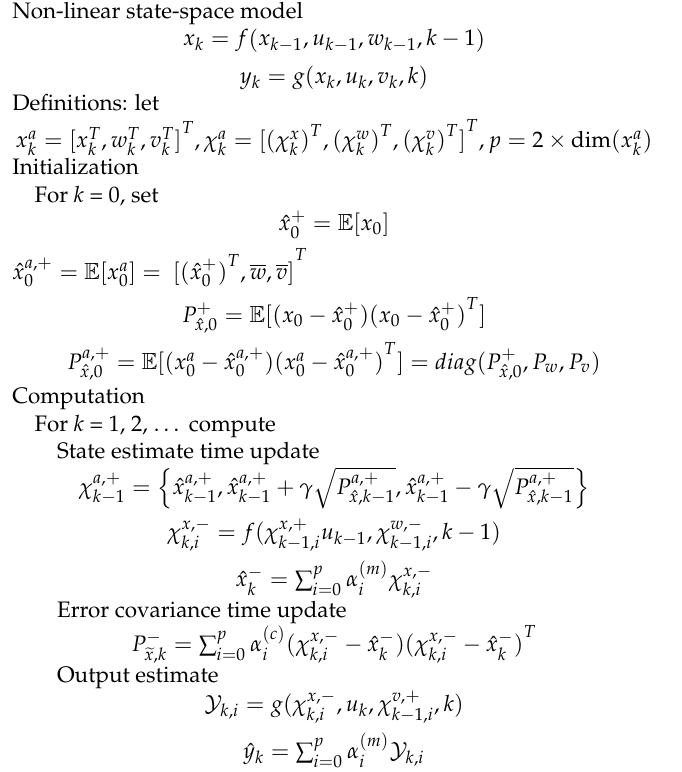
Table 7. Summary of the sigma-point Kalman filter for SOC estimation [103,104]. Non-linear state-space